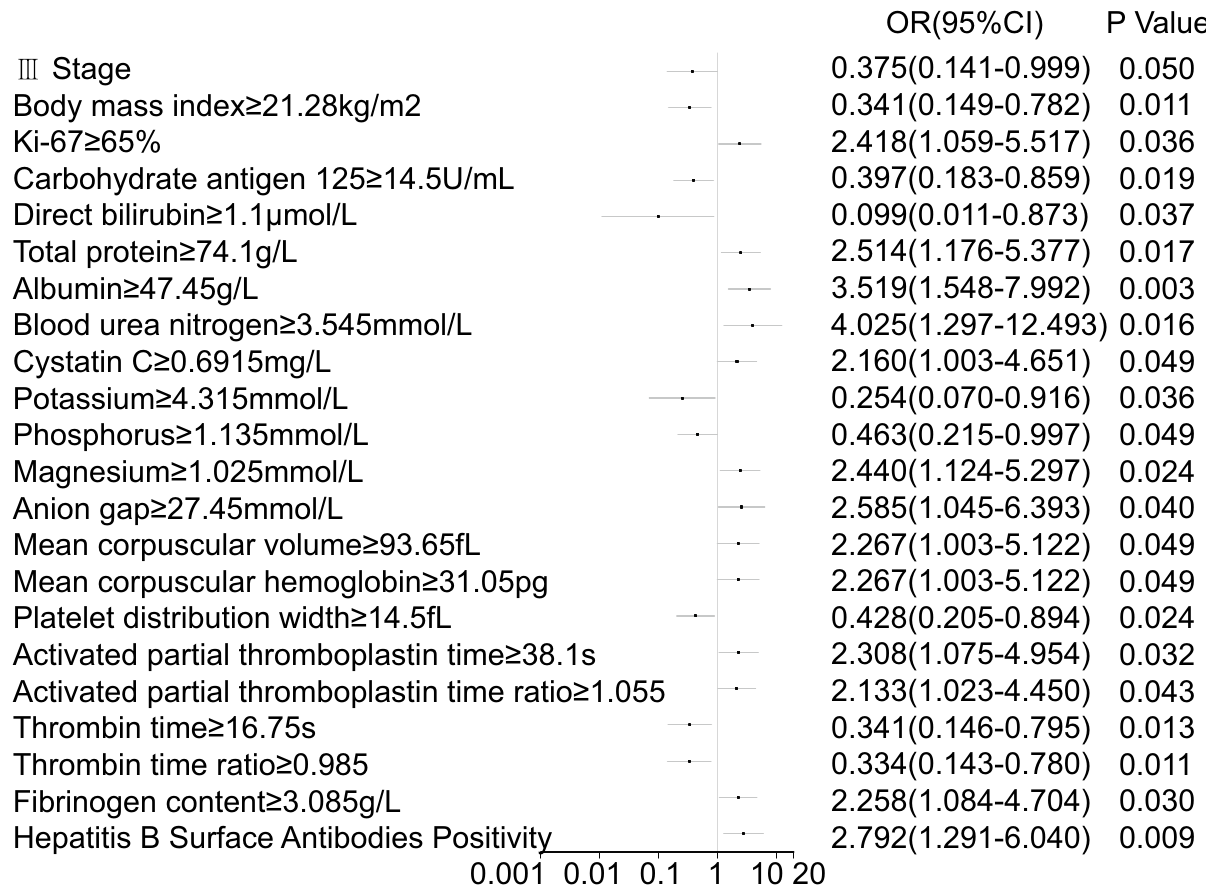
Figure 1. Single-factor logistic regression-based Forest plot analysis of the clinicopathological characteristics and serological indicators of 130 breast cancer patients related to breast pathologic complete response rate after neoadjuvant